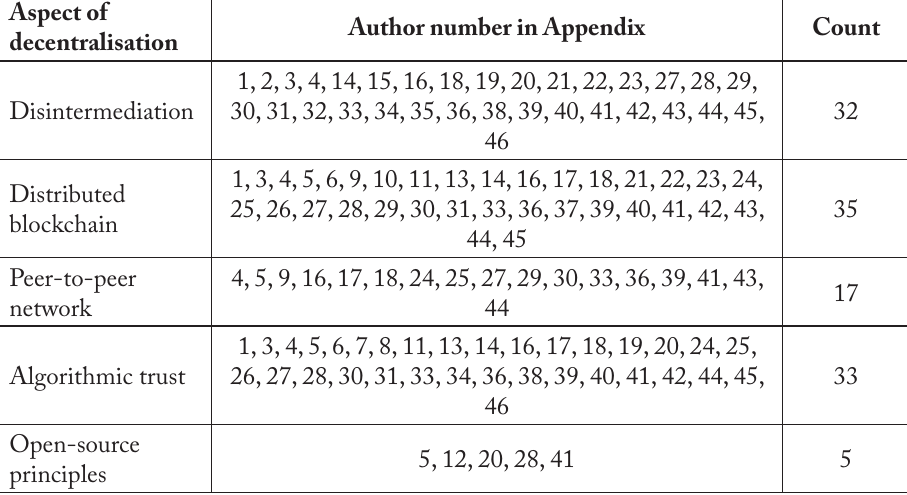
Table 1: Aspects of decentralisation identified from the literature Aspect